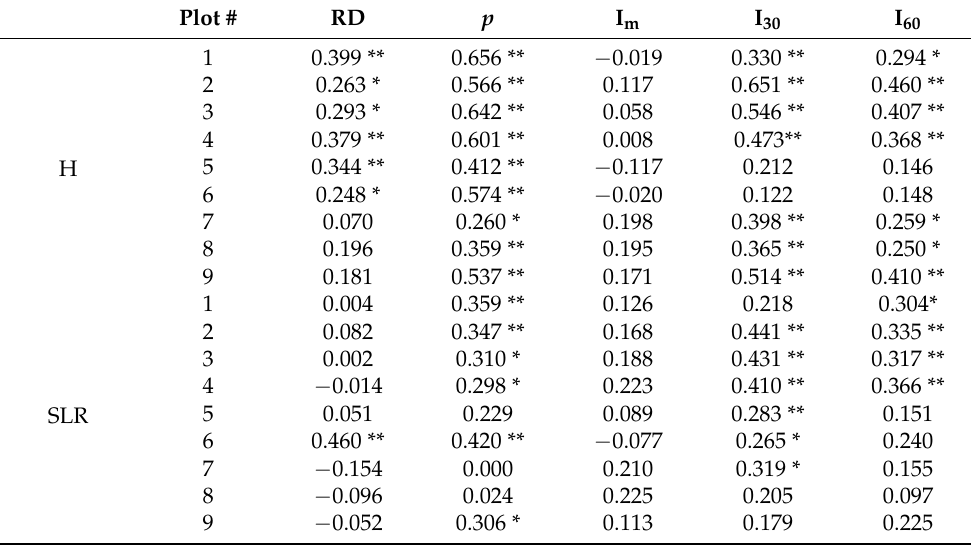
Table 4. Pearson correlation coefficients between rainfall eigenvalues (i.e., P, I 30 , I 60 , I m ) and runoff, and soil loss rate for the selected runoff plots in